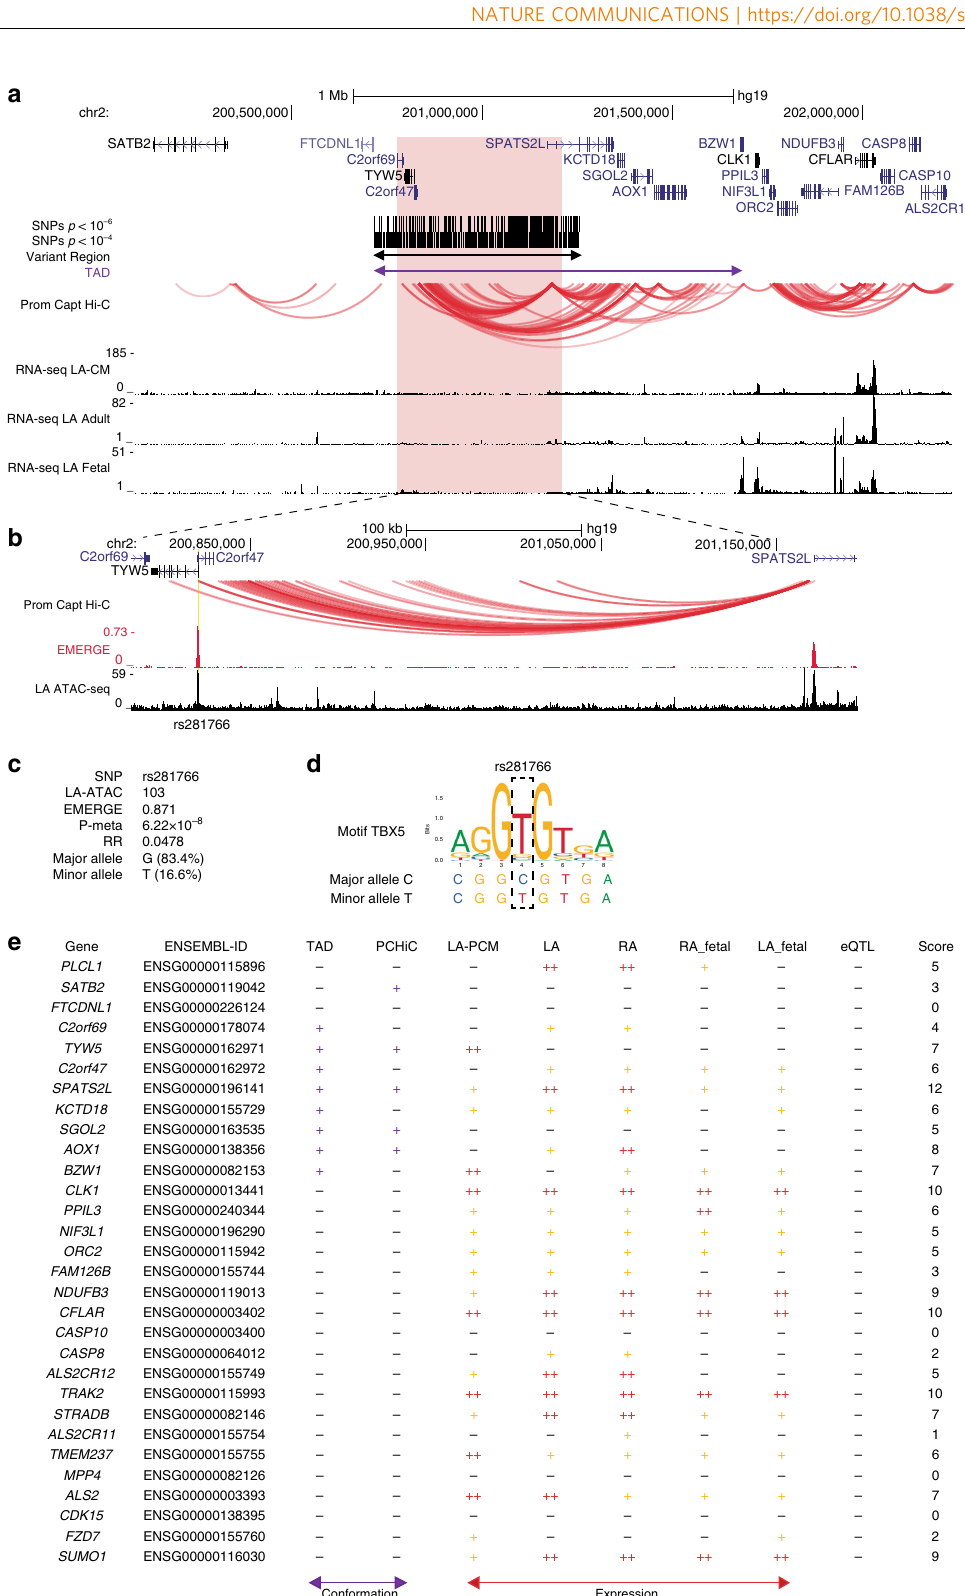
Fig. 3 Target genes and variant enhancer of SPATS2L locus. a SPATS2L locus showing TAD, variant region, (sub)threshold variants, CM PCHi-C, and RNA- seq. b Zoom of part of the variant region, showing PCHi-C and epigenetic datasets EMERGE and LA ATAC-seq. rs281766 is highlighted in yellow. c Information of variant rs281766, d TBX5 recognition motif and minor and major alleles of variant rs281766. e Table showing PCHi-C interaction with variant regions, expression per gene and fi nal scores for the analyzed genes. TAD Topologically Associated Domain, CM cardiomyocyte, PCHi-C promoter capture